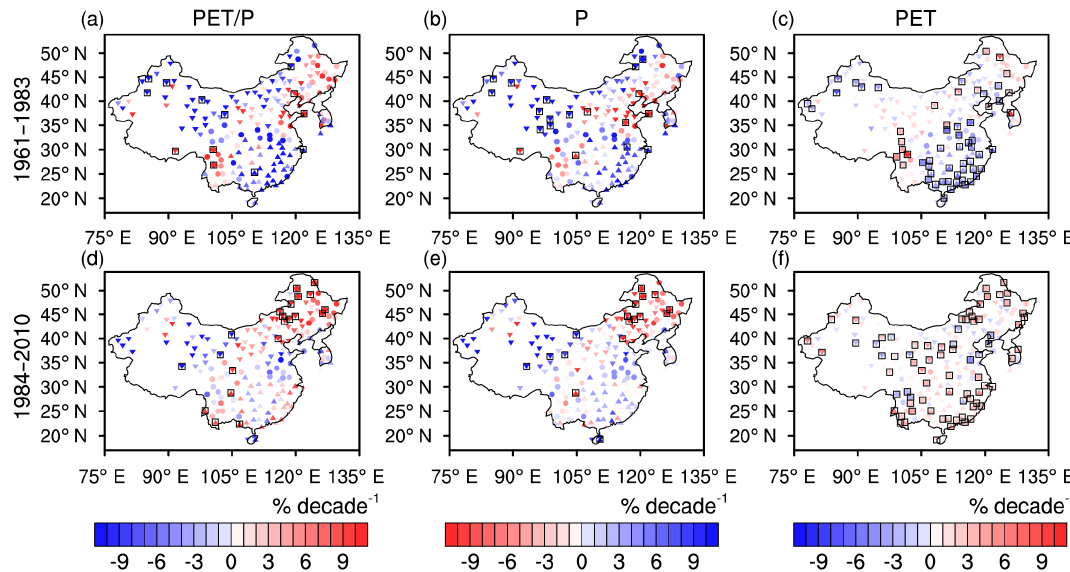
Figure 5. Spatial distributions of the trends in PET /P , P , and PET over continental eastern Asia. (a–c) The spatial distribution of trends in the annual mean PET /P (a) , P (b) , and PET (c) for the period of 1961–1983. Panels (d–f) as (a–c) , but for the period 1984–2010. Inverse triangles, circles, and triangles represent stations classified as arid, transitional, and humid regions, respectively. The open squares indicate that the trend is significant at the 95% confidence